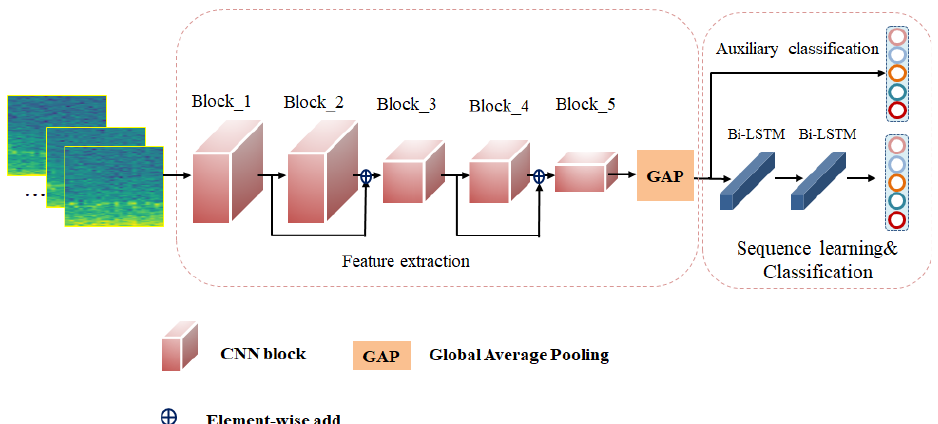
Figure 6. The model EEGSNet structure mainly consists of feature extraction and sequence learning. Feature extraction is where the model extracts features from the EEG spectrogram by means of 5 convolutional blocks. The features are then transferred to the sequential learning part to obtain the transition relationships between sleep stages. Auxiliary classifier is also used to help train the net- work.